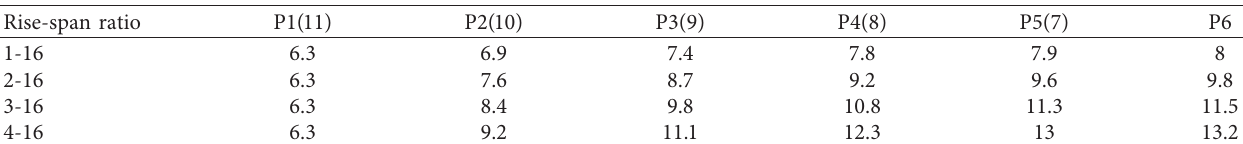
Table 1: Pile length (unit: m).